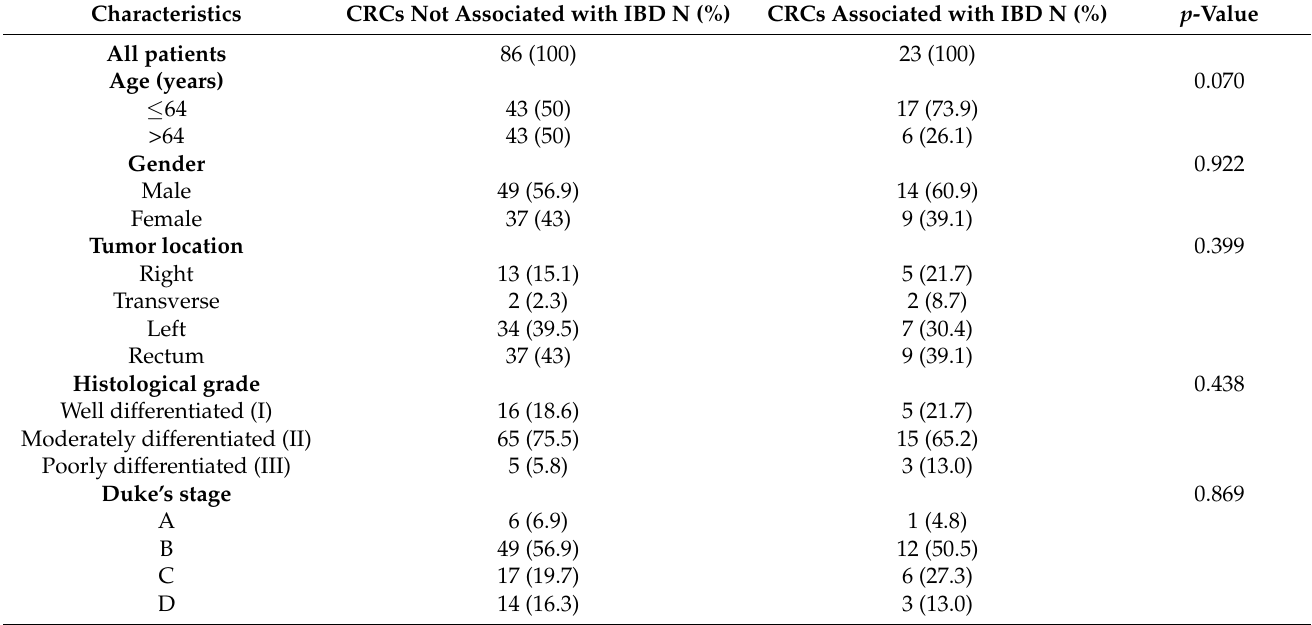
Table 1. Basal characteristics of 109 patients with colorectal cancer.